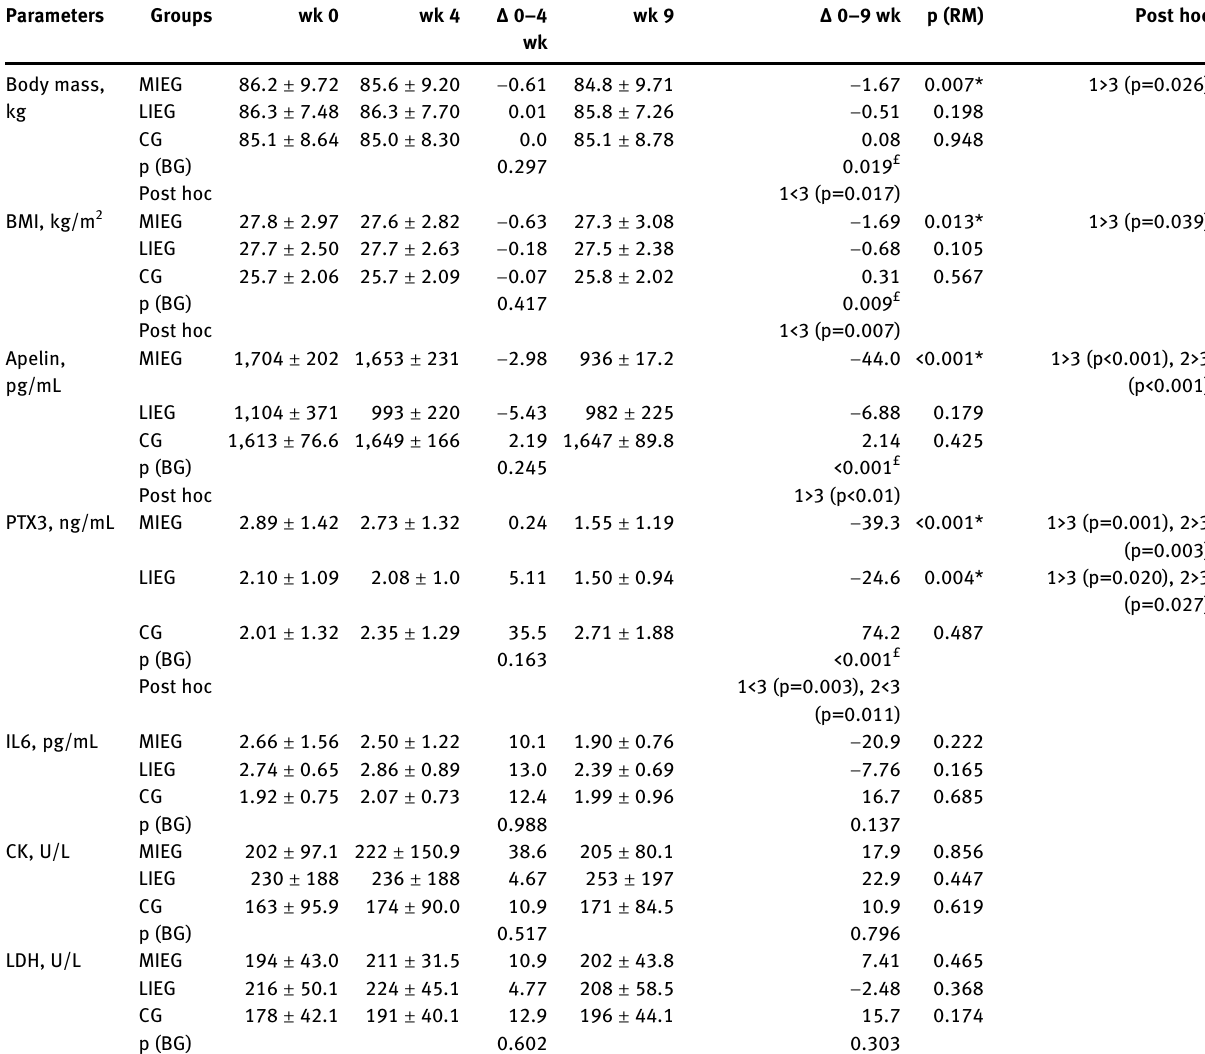
Table  : Chance of physical and cardiovascular risk markers after eight wk of resistance training with different intensities. Parameters